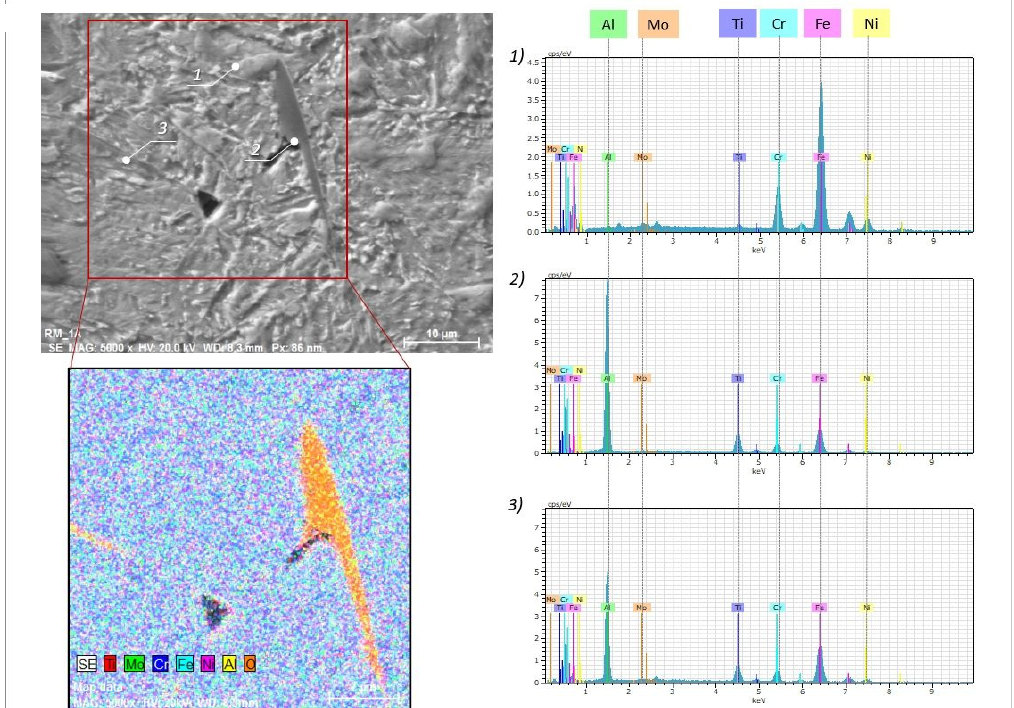
Figure 10. Chemical compositions within the area and from corresponding points marked in white of the M789 maraging steel. Table 4. The chemical composition of the phases within the microstructure of M789 maraging steel.